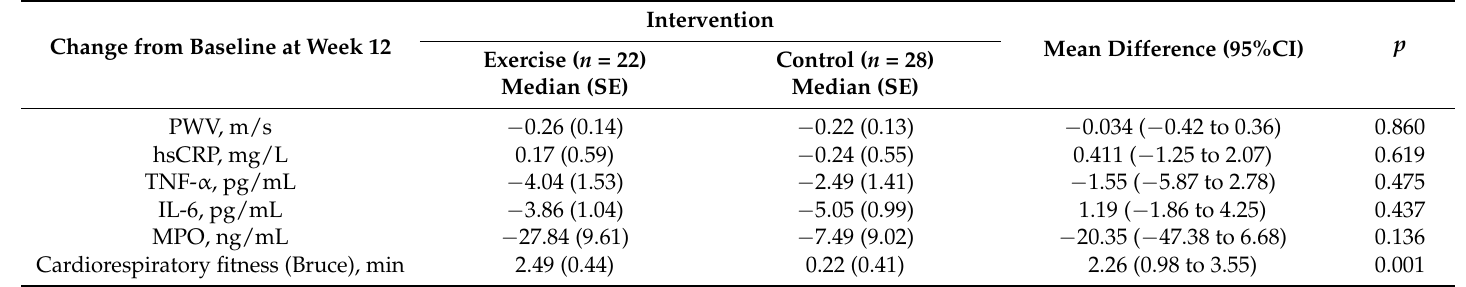
Table 3. Per-protocol (primary) analyses assessing the effects of 12-week progressive aerobic exercise on arterial stiffness, inflammation, oxidative stress, and cardiorespiratory fitness in women with systemic lupus erythematosus (participants in the exercise group were included if attendance was ≥ 75%).